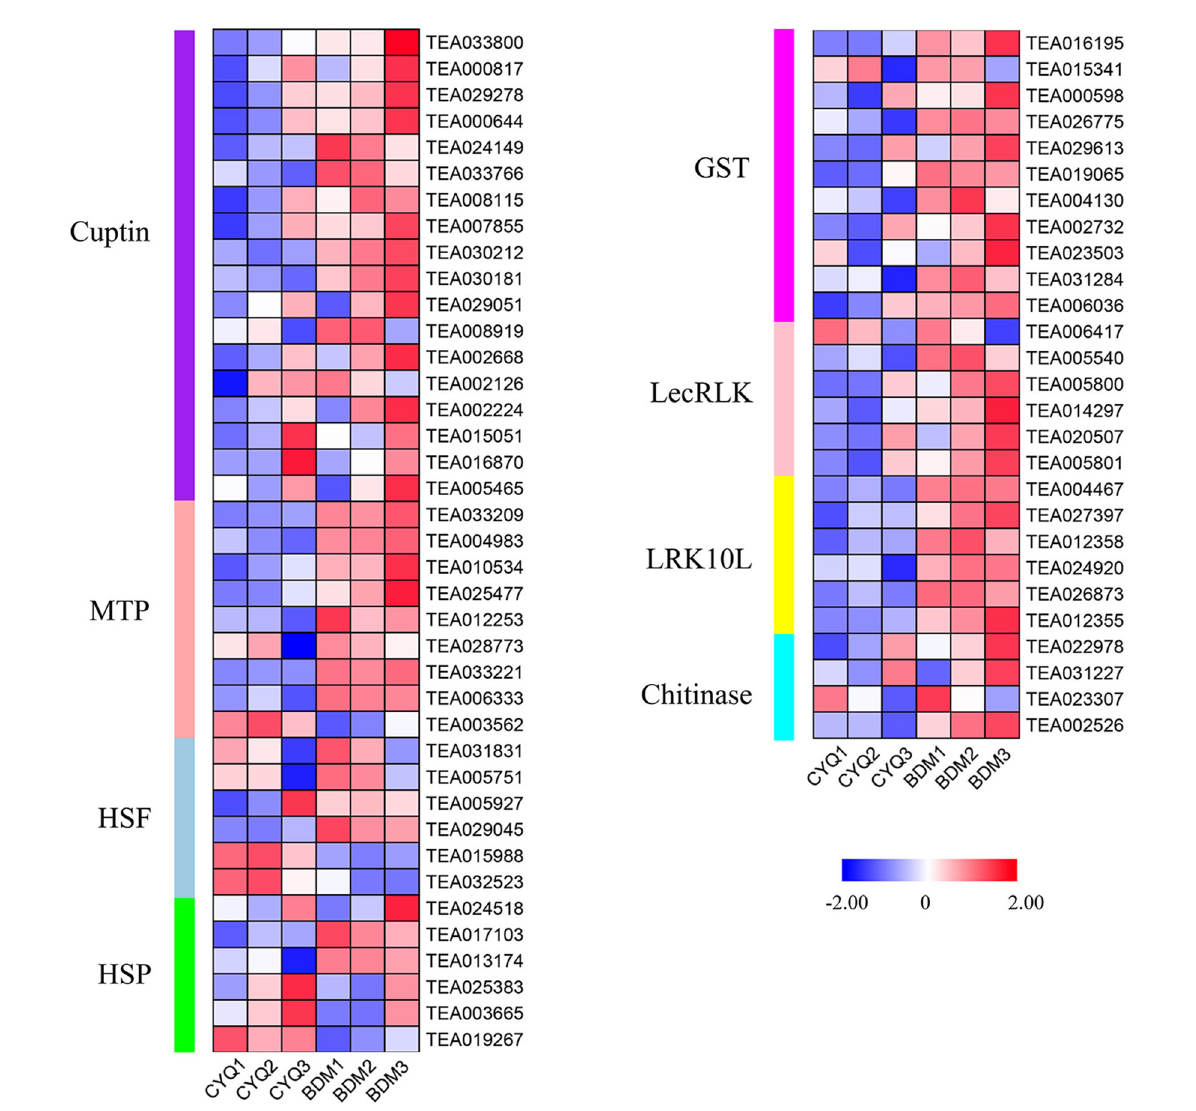
FIGURE6 The expression pattern of plant resistance genes (PRGs). DEGs related to PRGs. The expression levels of DEGs were normalized by log 2